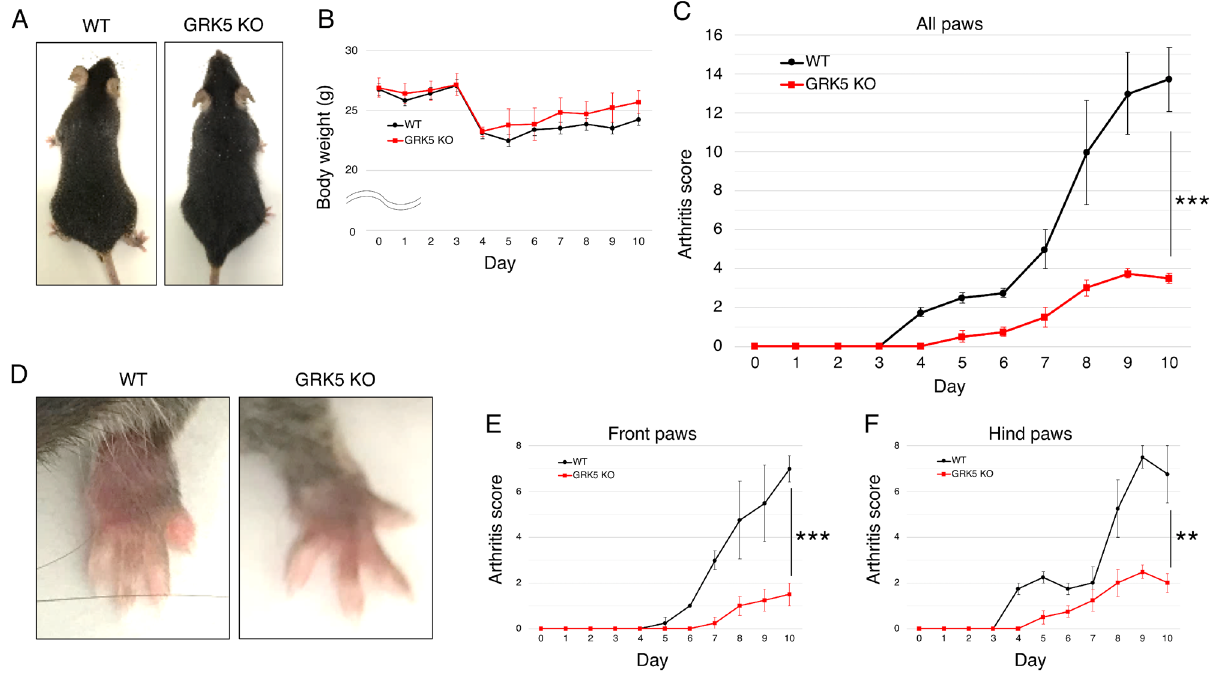
Figure 3. In vivo effects of GRK5 knockout on joint swelling in a murine model of CAIA. ( A ) Development and growth of WT mice and GRK5 knockout (KO) mice. ( B ) Changes in body weight over time in GRK5 KO and WT mice during CAIA. ( C , E , F ) Changes in arthritis scores over time in GRK5 KO and WT mice during CAIA. Each leg was assessed using a scale of 0 to 4. ( C ) Total clinical arthritis score ranged from 0 to 16. Arthritis score of ( E ) front paws and ( F ) hind paws ranged from 0 to 8. Values are means ± SD (n = 4). ** P < 0.01; *** P < 0.001 versus WT mice. ( D ) Representative macroscopic appearance of GRK5 KO and WT mice 10 days after CAIA